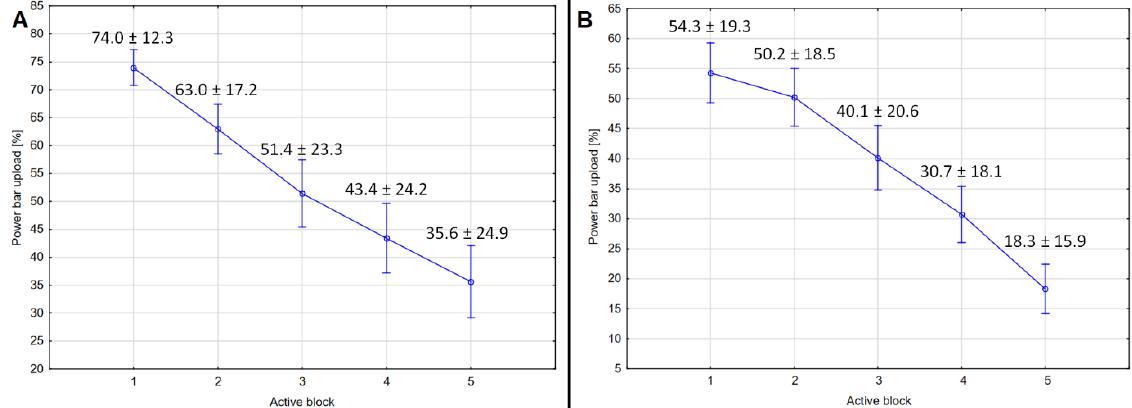
Figure 1. Plots indicating squeezing effectiveness for gamified ( A ) and standard ( B ) paradigms. The mean value and standard deviation for each block are presented above whiskers.